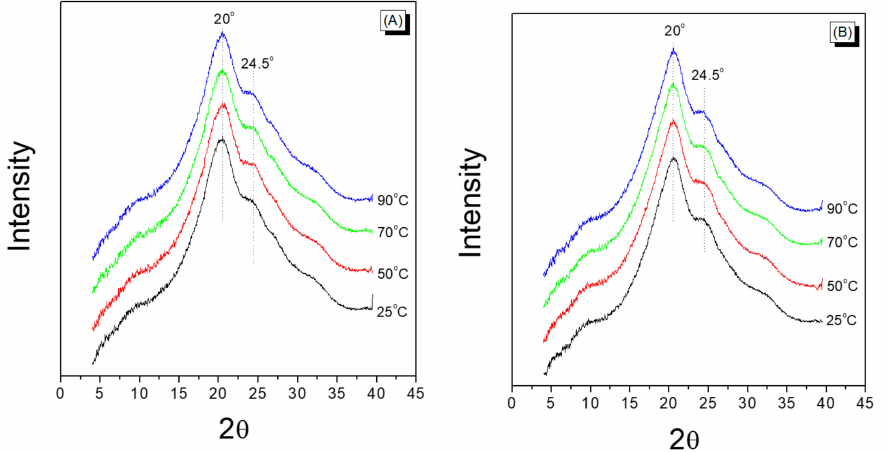
Figure 7. X-ray diffractograms of ( A ) silk web and ( B ) silk non-woven fabrics prepared at various reeling bath temperatures. The reeling velocity was 39.2